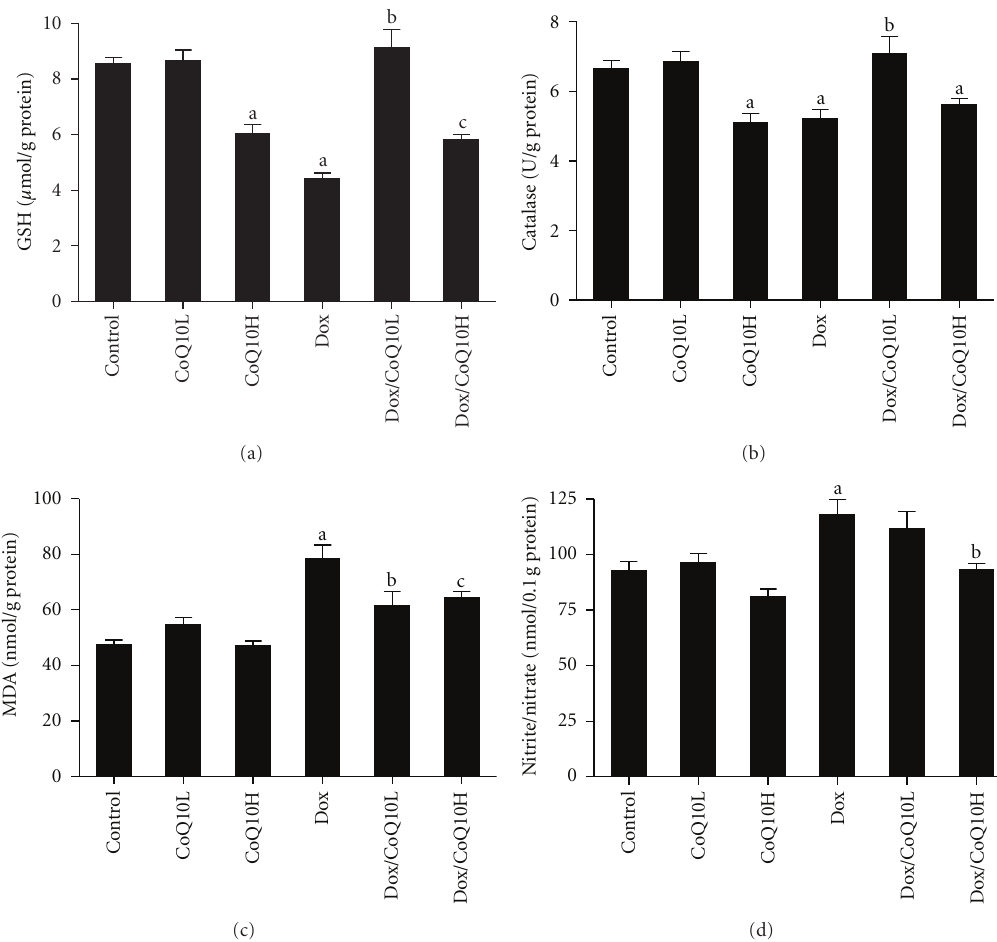
Figure 1: E ff ect of low and high doses of coenzyme Q10 (CoQ10) on renal (a) reduced glutathione (GSH), (b) catalase, (c) malondialdehyde (MDA), and (d) nitric oxide (nitrite/nitrate) levels in rats exposed to doxorubicin- (Dox-) induced nephrotoxicity. Animal groups tested are control-untreated group, animals treated with low or high dose CoQ10 alone (CoQ10L or CoQ10H, resp.), and animals treated with Dox or with Dox together with low or high CoQ10 dose (Dox/CoQ10L or Dox/CoQ10H, resp.). Values are represented as means ± SE of 6–11 observations. a Significant di ff erence compared to control, b significant di ff erence compared to Dox, without significant di ff erence from control, and c significant di ff erence compared to Dox, with significant di ff erence from control. Significant di ff erence is reported when P < 0 .